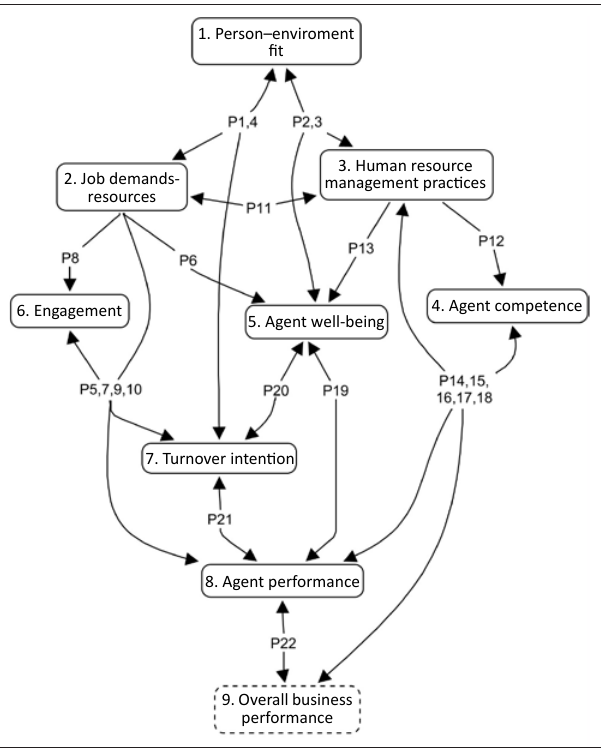
FIGURE 2 : A human capital predictive model for agent performance in contact